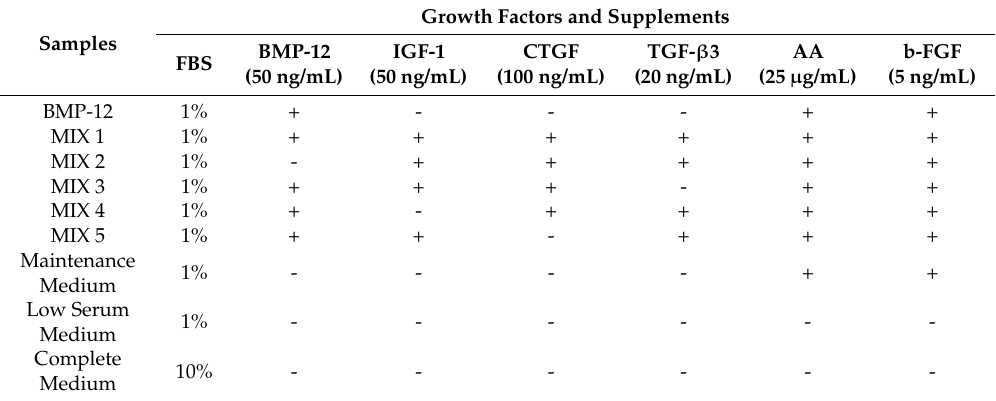
Table 1. Tenogenic media composition with different combinations of growth factors and supplements.